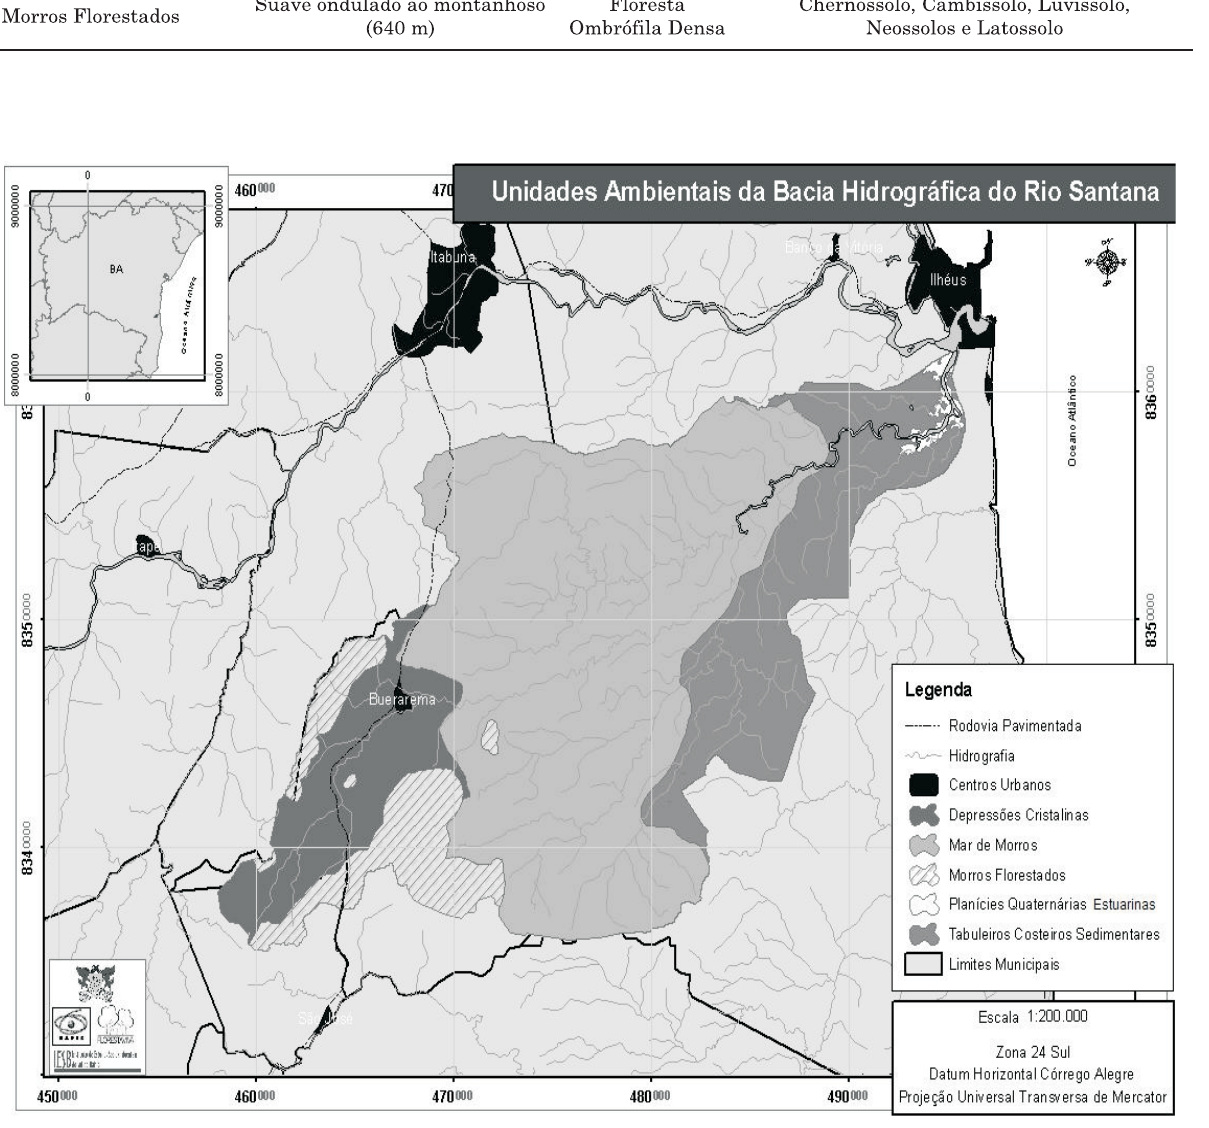
Figura 1 - Unidades Ambientais da Bacia Hidrográfica do Rio